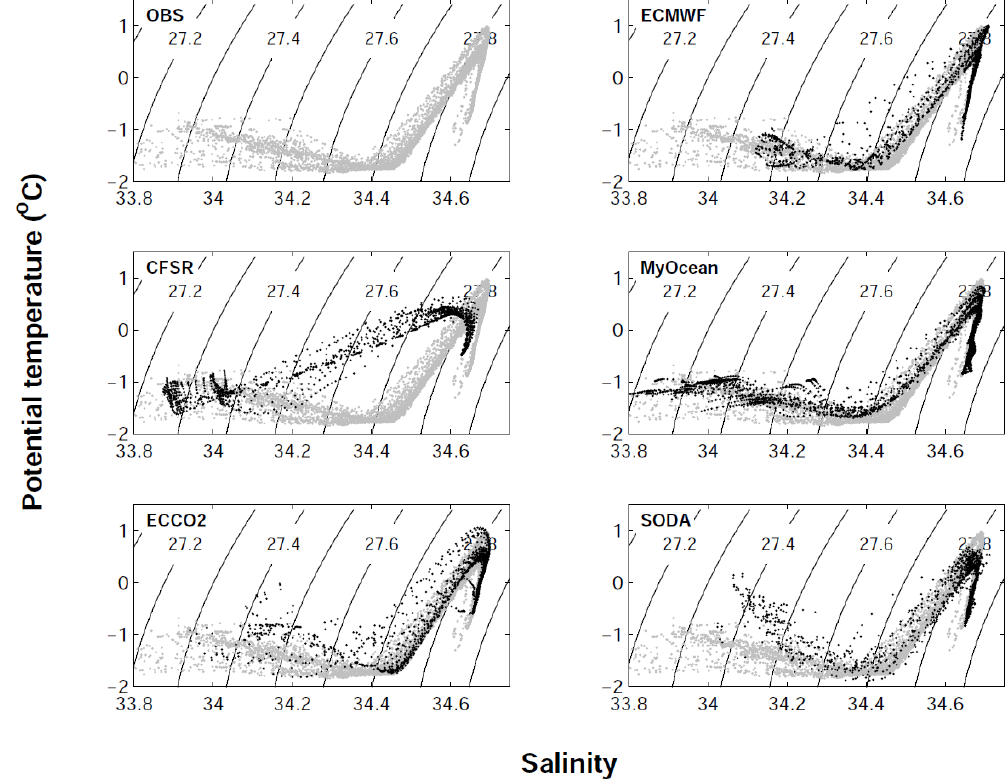
Figure 3. Same as in Fig. 2, but for section WOCE SR4. 1093